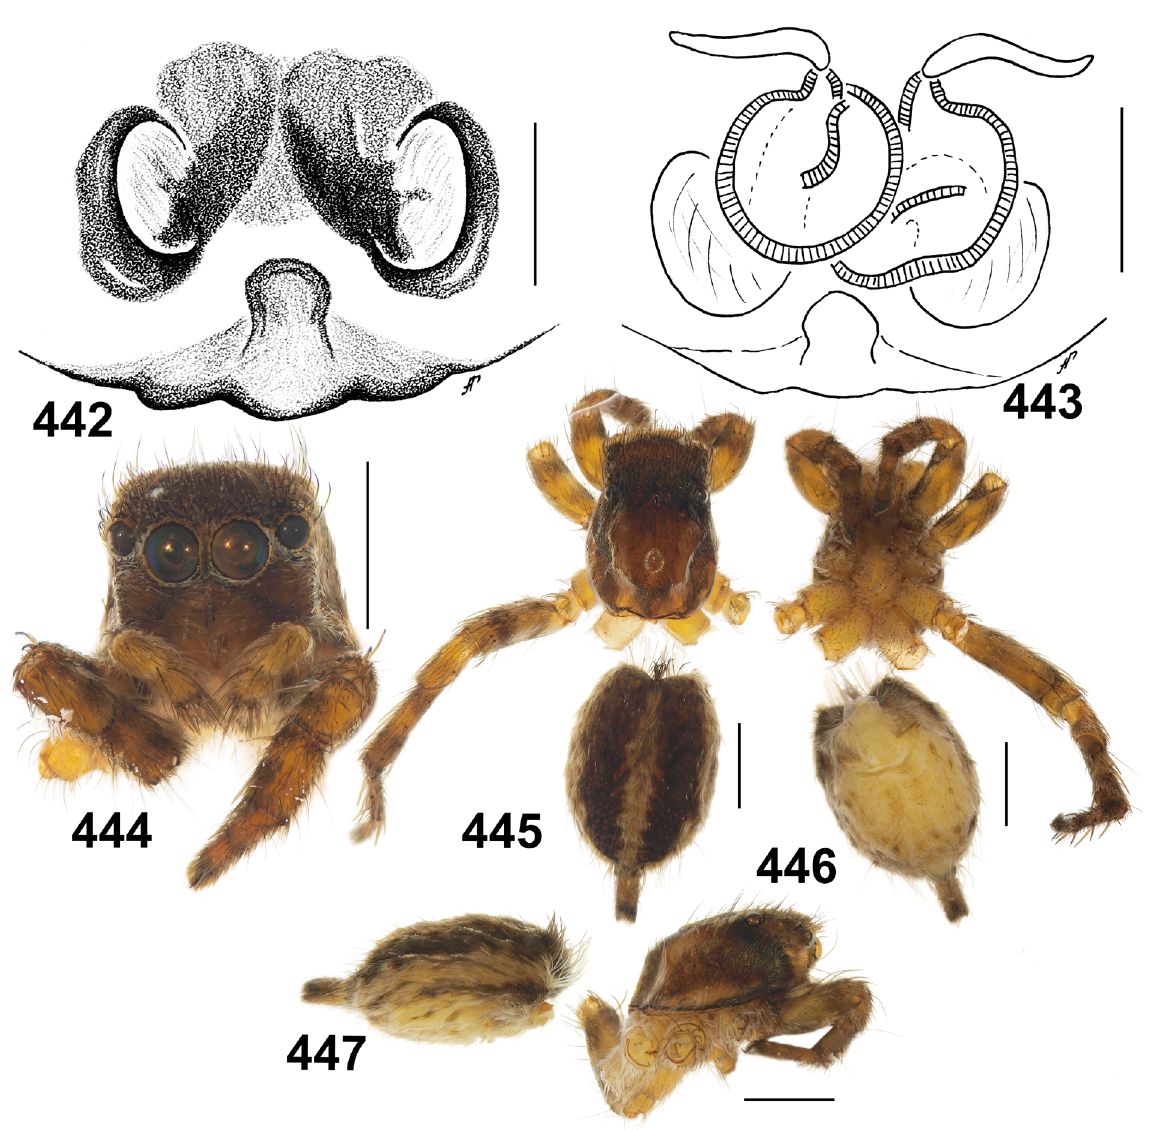
Figs 442–447. Stenaelurillus siyamae sp. nov., holotype, ♀ . 442 . Epigyne, ventral view. 443 . Spermathecae, dorsal view. 444 –447 . General appearance. Scale bars: 442–443 = 0.1 mm; 444–447 =